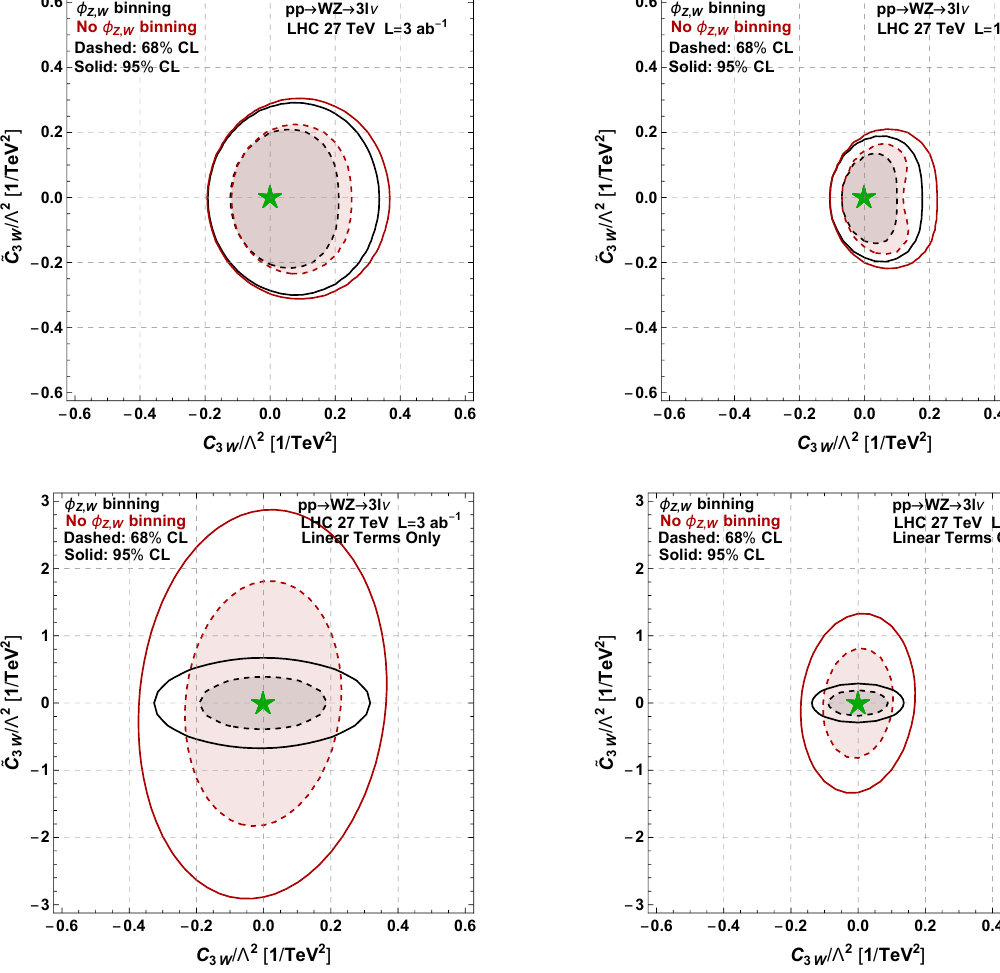
Figure 10 . 68% (dashed) and 95% (solid) posterior probability contours for the WZ at 27 TeV analysis with (black) and without (red) the binning in the (cid:30) Z and (cid:30) W angles, see main text for more details. Only events with m T < 1 : 5 TeV are used. The upper and lower panels correspond WZ to the limits obtained with and without the inclusion of the quadratic term in the EFT expansion